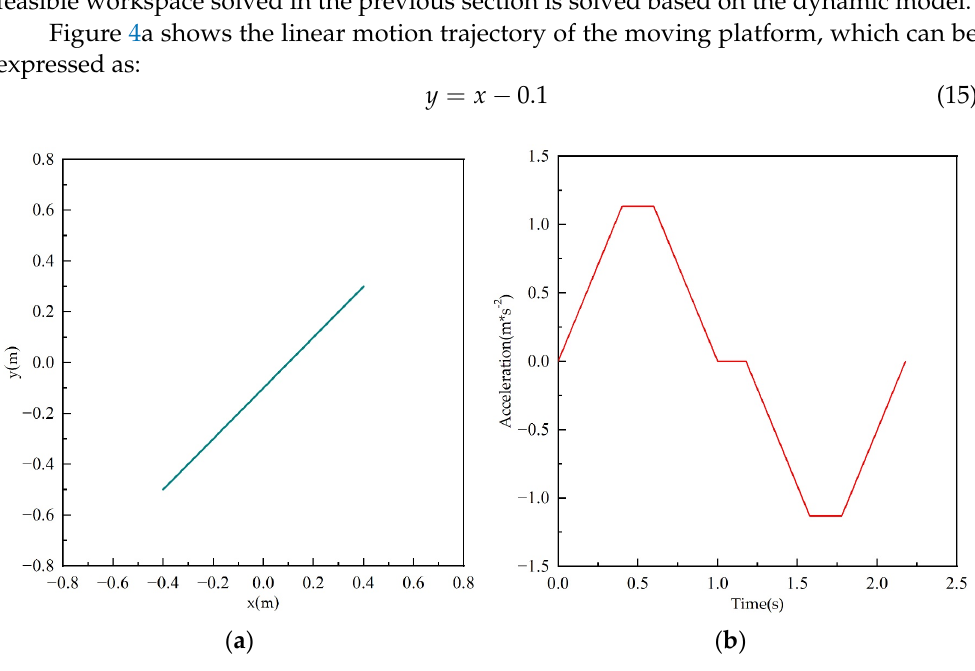
Figure 4. Linear motion trajectory and acceleration of moving platform. ( a ) Motion trajectory; ( b ) Acceleration curve.